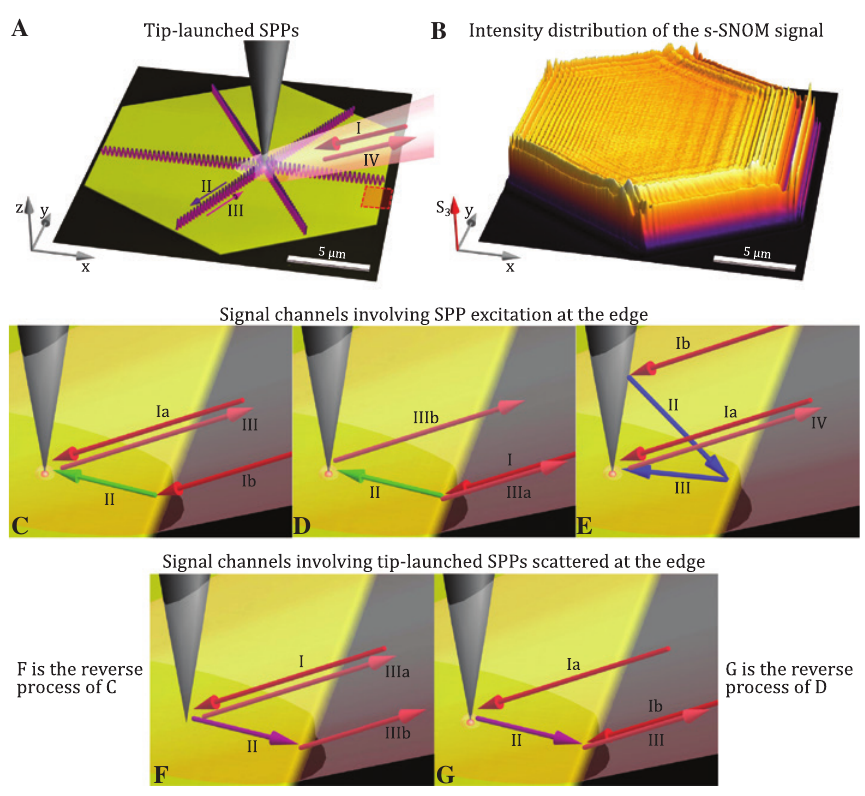
Figure 2: Excitation channels of SPPs contributing to the measured intensity distribution. (A) AFM topography of a mono-crystalline gold platelet and illustration of tip-launched SPPs. (B) 3D plot of the intensity distribution of the s-SNOM signal. (C) Illustration of edge-launched SPPs which interfere with the backscattered light from the tip. (D) Illustration of edge- launched SPPs which interfere with the backscattered light from the edge. (E) Illustration of tip-reflected edge-launched SPPs and (F, G) illustration of the reverse signal channels shown in C and D, respectively, in which tip-launched SPPs are scattered into free space in the direction of the detector; these signal channels yield the same fringe spacing as C and D but with different intensities. The respective positions of the view windows shown in C–G are indicated by the red dashed